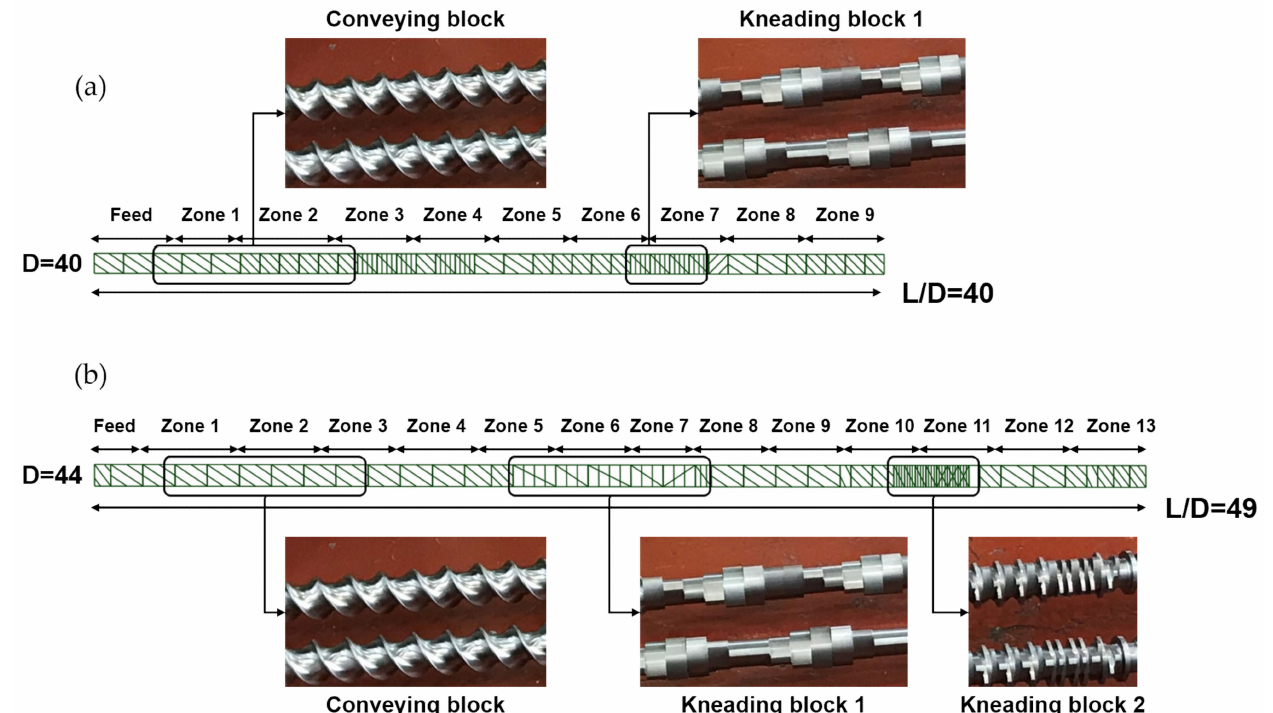
Figure 1. Schematic configurations of ( a ) mild and ( b ) harsh screws in twin-screw extruders. In the extrusion processing of PP polymers through mild and harsh twin-screw con- figurations, three process parameters (i.e., the peroxide content, the screw speed, and the extrusion temperature) were mainly changed in the consideration of PP intrinsic properties to manufacture extruded CR-PPs. The screw speed was set to 200 and 250 rpm and a vacuum pump was installed in the extruder to remove volatile materials. The PP extrudate strands at the die exit were cooled rapidly in a long water bath and pelletized. Peroxides from 0 to 600 ppm were mixed with the PP resin before extrusion. The temperature in each screw zone specified in Figure 1 was set in Table 1 for mild and harsh extrusion conditions. The temperature condition in the last screw zones, where a polymer melt exits the extruder, was named set